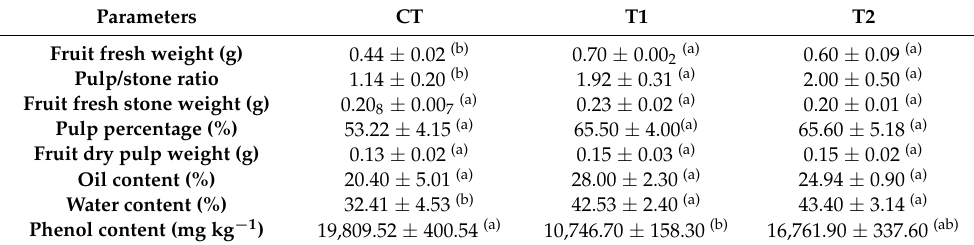
Table 1. Changes in fruit fresh weight, pulp/stone ratio, fruit fresh stone weight, pulp percentage, fruit dry pulp weight, oil content, water content, and phenol content after treatment with wastewater irrigation (T1 and